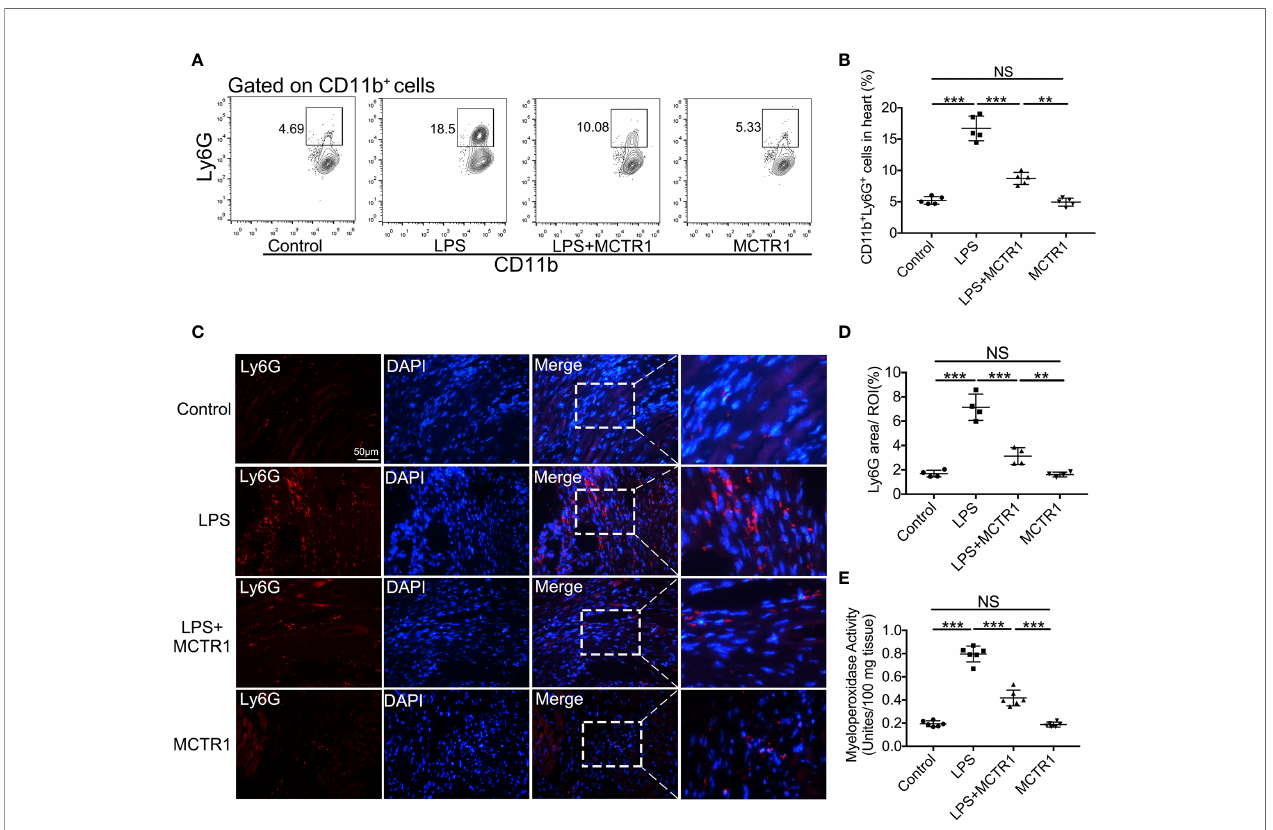
FIGURE 4 | MCTR1 reduced neutrophils in fi ltration in LPS-induced cardiac injury. (A) The representative fl ow cytometry dot plots of CD11b + Ly6G + neutrophils in fi ltrated in myocardium. (B) Percentage of CD11b + Ly6G + neutrophil population in the hearts (n = 4). (C) Representative immuno fl uorescence staining of Ly6G in hearts. (D) Fluorescence intensity of Ly6G was determined by Image J software (n = 4). (E) Cardiac MPO activity was examined by MPO test kit (n = 6). Data are shown as means ± SD. ** P < 0.01; *** P < 0.001; NS, not signi fi